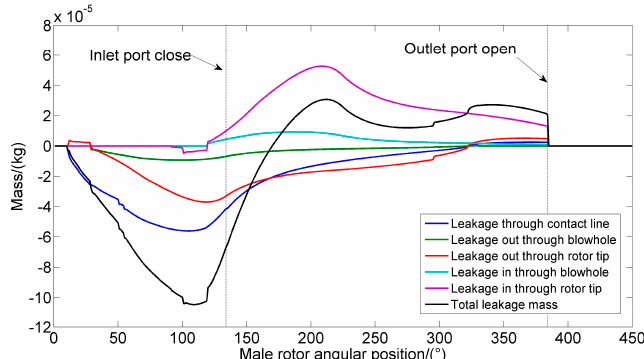
Figure 10. Simulated leakage mass over the rotation angle of the male rotor during the expansion process ( P i = 1.3 MPa, T i = 192 °C, m t = 20 t/h, P o = 0.19 Mpa, n = 2400 rpm).